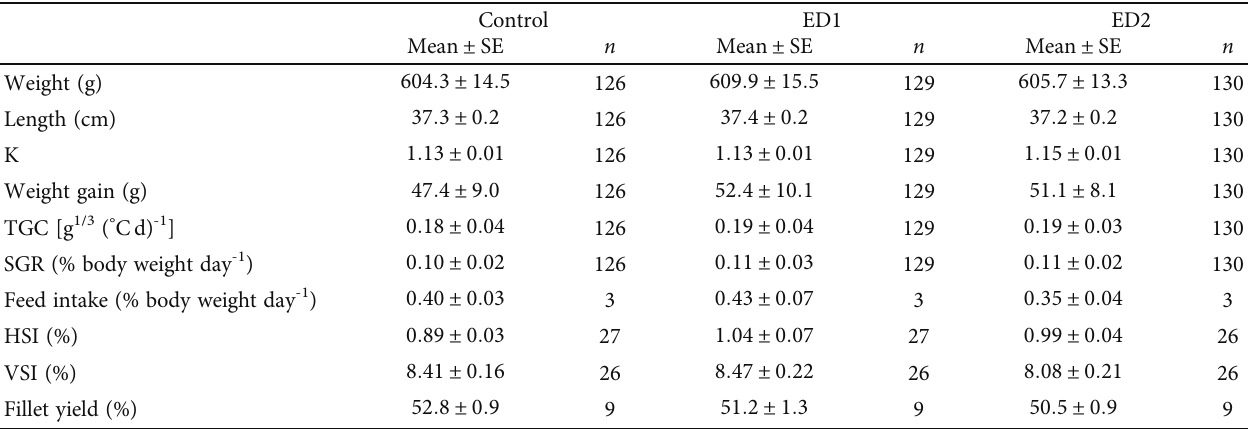
Table 5: Morphological and production metrics for Atlantic salmon after 65 days fed either the control diet, experimental diet # 1 (ED1), or experimental diet # 2 (ED2). Fish were fed these diets as temperature was maintained at 16 ° C for 3 weeks and then raised to 18 ° C where temperature was held for 5